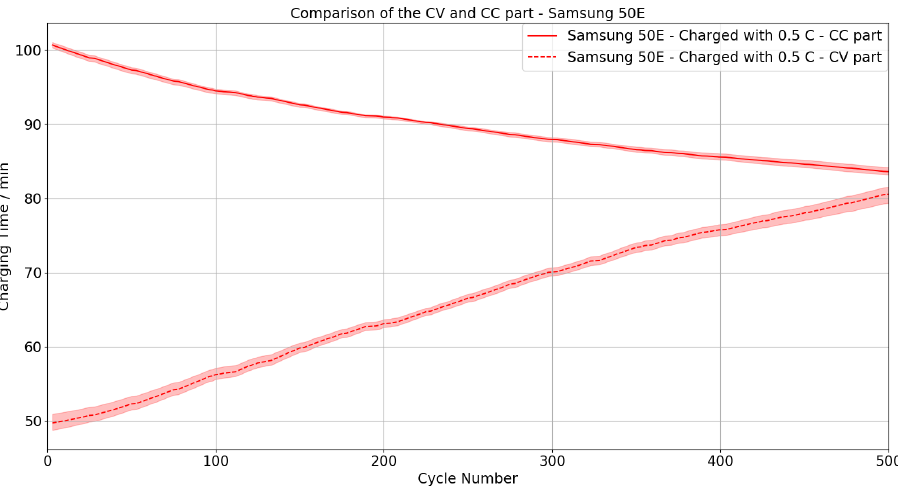
Figure 12. Development of the charging time during the cycle test. Separation of the CC and CV part for Samsung 50E.